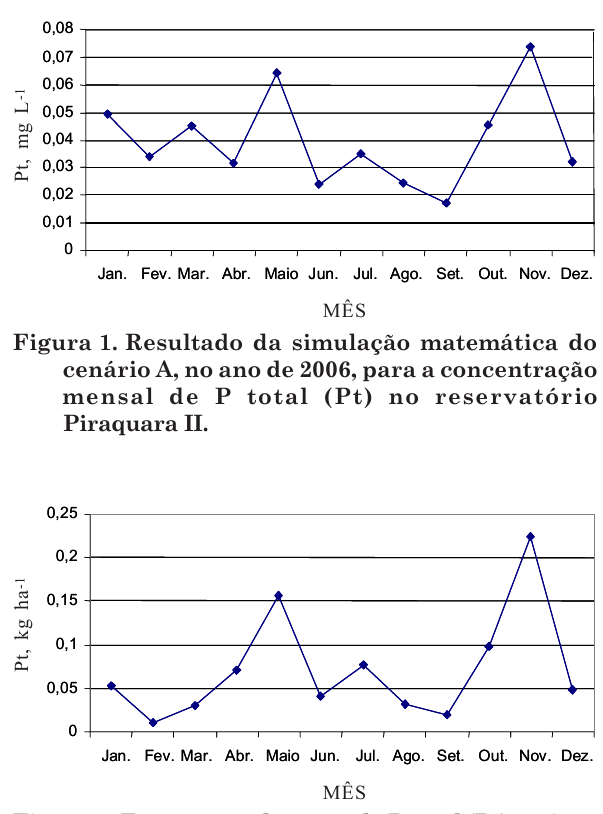
Figura 2. Exportação de carga de P total (Pt) na área de drenagem de contribuição ao reservatório Piraquara II.